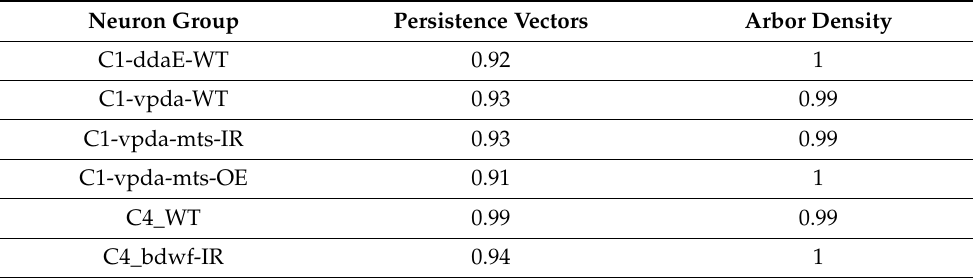
Figure 6. Sholl-Like Comparison Between Real and Simulated Neurons. Sholl-like analysis of total dendritic length against Euclidean distance from the soma for ( A ) Class I and ( B – D ) Class IV neurons. Lighter, broader shades of blue, red, green, pink, and brown represent different subclasses and genotypes of the real neurons. Darker, thinner lines in analogous colors represent the corresponding subclasses and genotypes of the simulated neurons. Table 4. False Discovery Rate-corrected t -test p values of comparisons for pairwise distances in persistence vectors or global density vectors between within-condition (real vs. real and simulated vs. simulated) and across-conditions (real vs. simulated) for all 17 cell groups. Values greater than 0.1 mean failure to reject the null hypothesis that the real and simulated neurons belong to the same